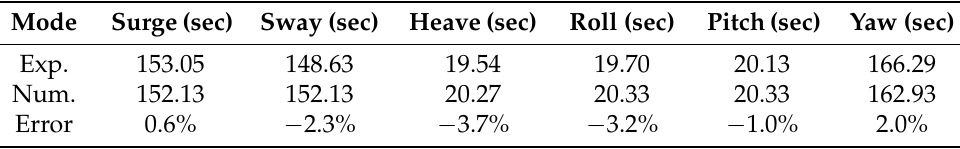
Table 4. Natural period of semi-submersible (real